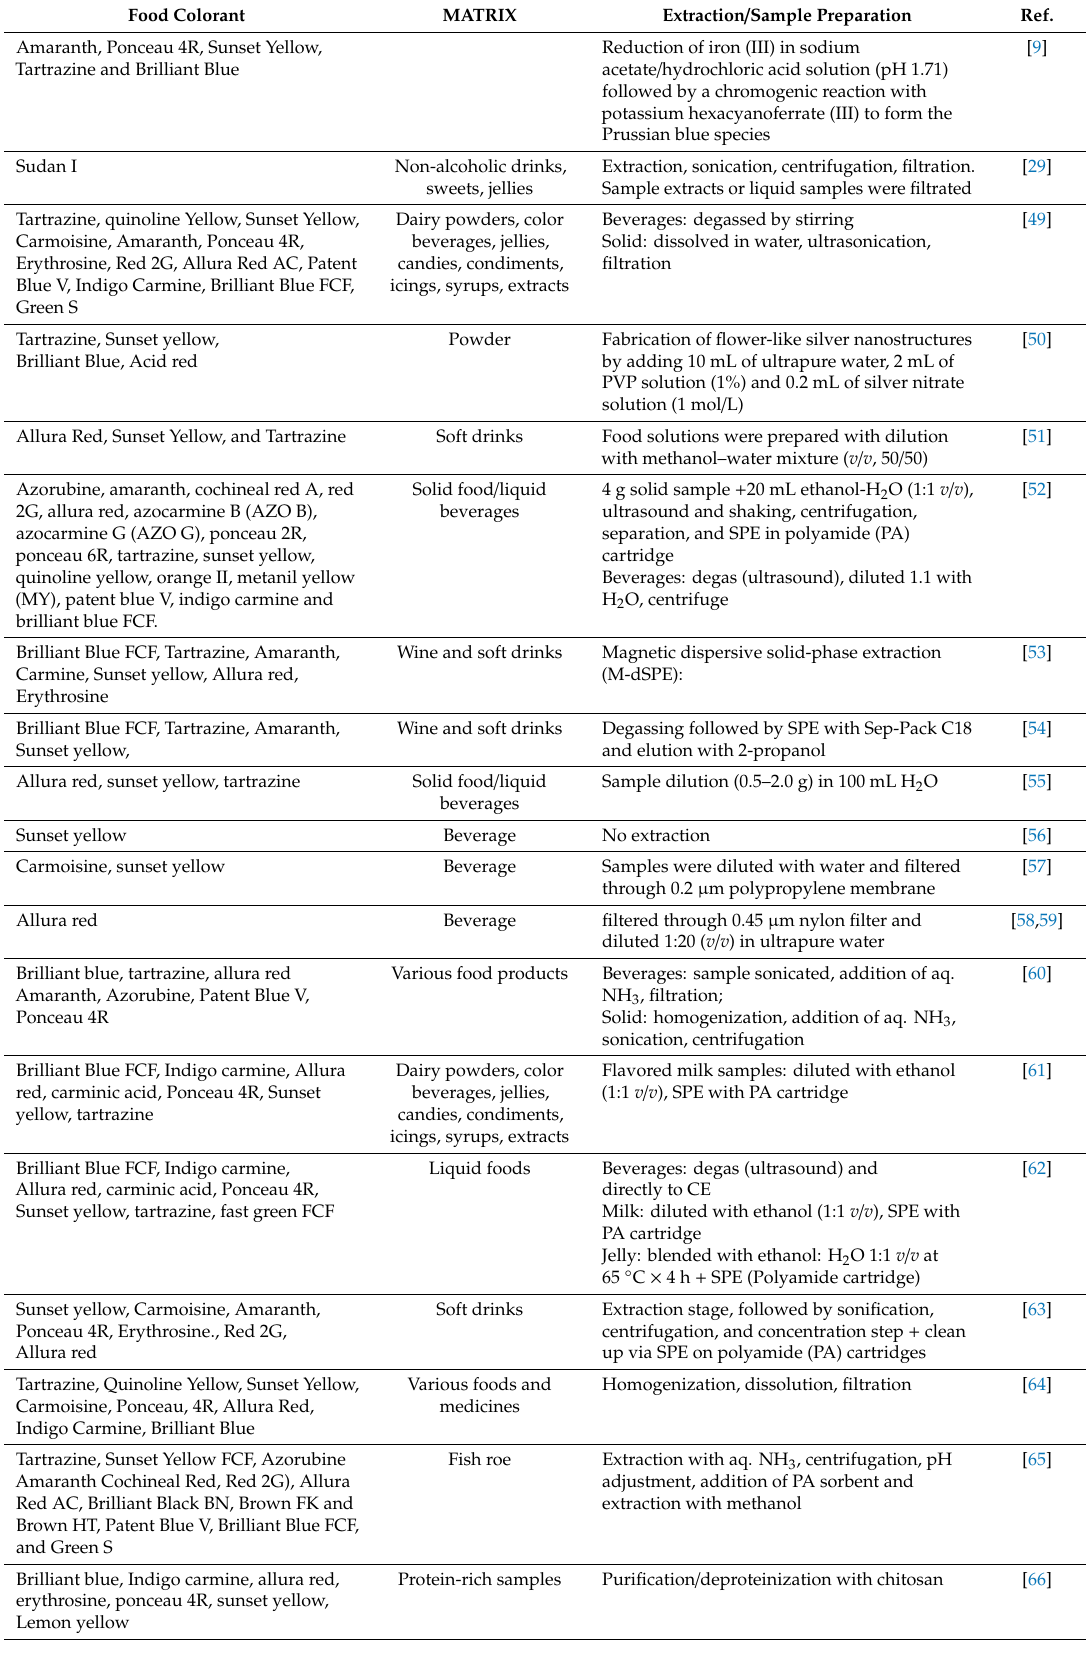
Table 4. Sample preparation techniques for the determination of synthetic food colorants in food samples.